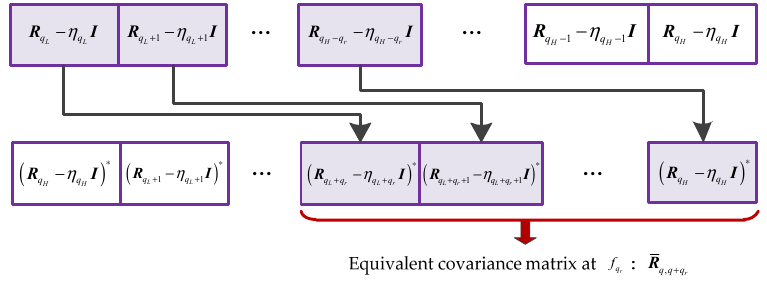
Figure 2. Principle diagram for the calculation of the equivalent covariance matrix. Given the Kronecker product between σ q and σ q + q in (5), the number of signals (i.e., r the incident signals and the cross terms) in the equivalent covariance matrix is K 2 . The condition that M (cid:48) > K 2 should be satisfied to identify all the